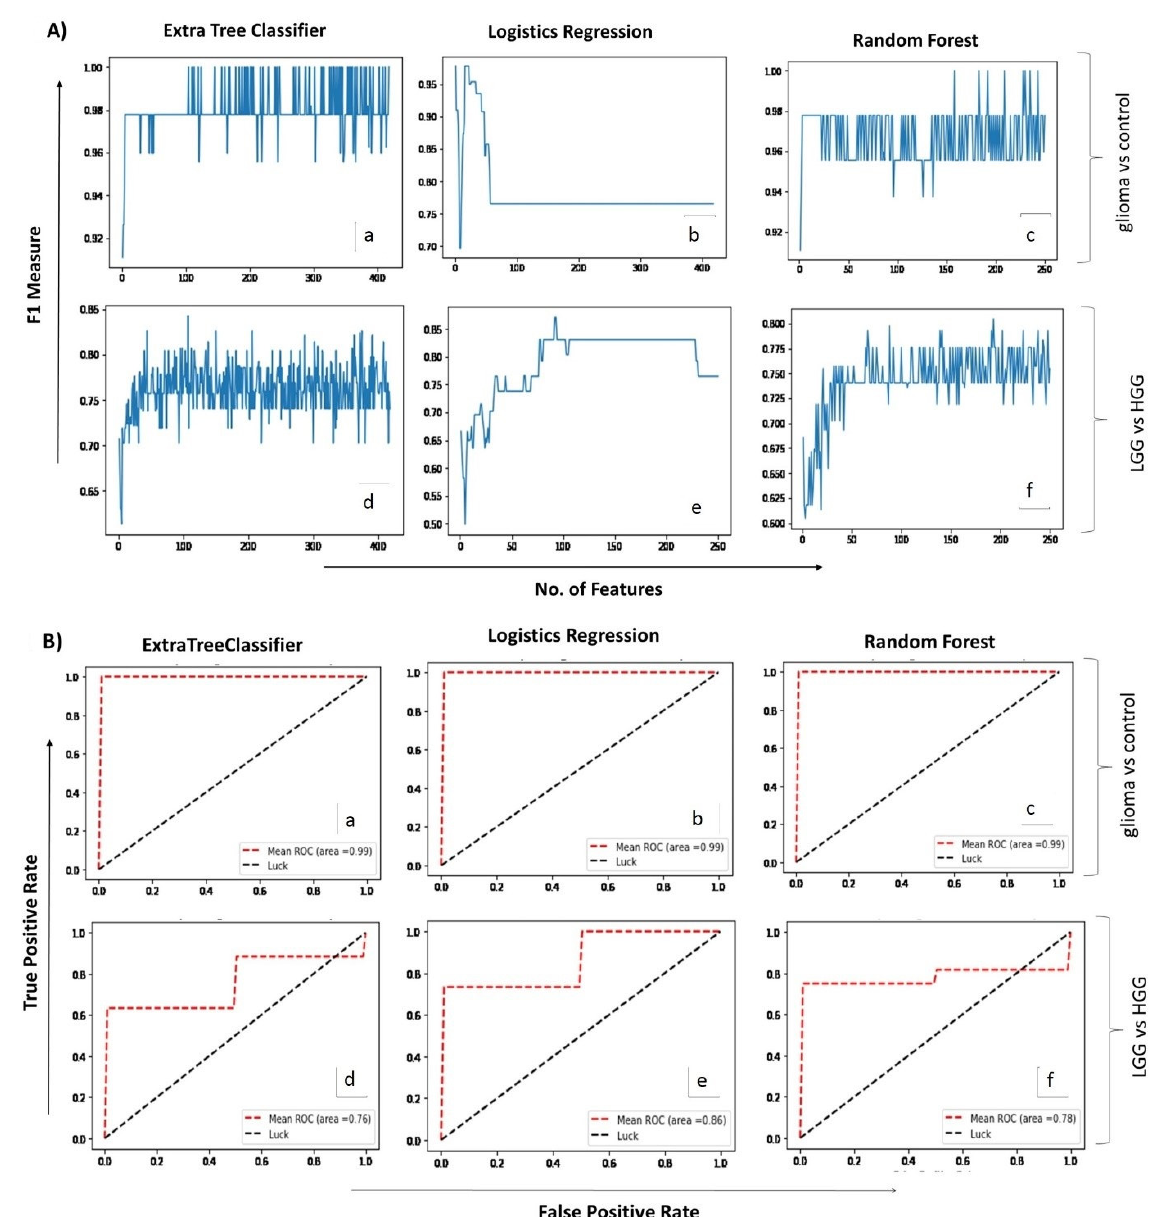
Figure 2. ( A ). Mean score plots displaying the number of features (x-axis) and the corresponding F1 measures (y-axis) obtained for each of the three ML algorithms applied (i.e., extra tree classifier, logistic regression & random forest) for glioma vs control ( a – c ) and LGG vs HGG analysis ( d – f ), respectively. ( B ). Receiver operating curve (ROC) plots depicting predictive accuracy of the three ML algorithms for glioma vs control ( a – c ) and LGG vs HGG ( d – f ) groups, respectively. X-axis shows false positive rate while Y-axis indicates true positive rate on a scale of 0 to 1.0.